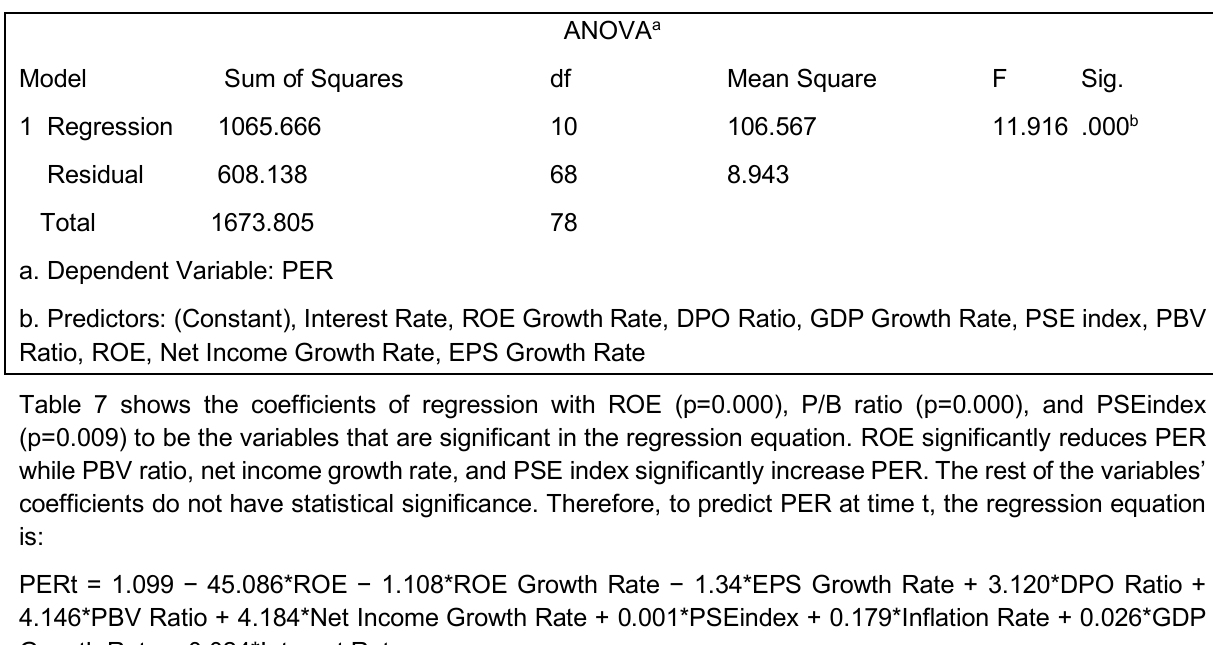
Table 6: Analysis of Variance Summary